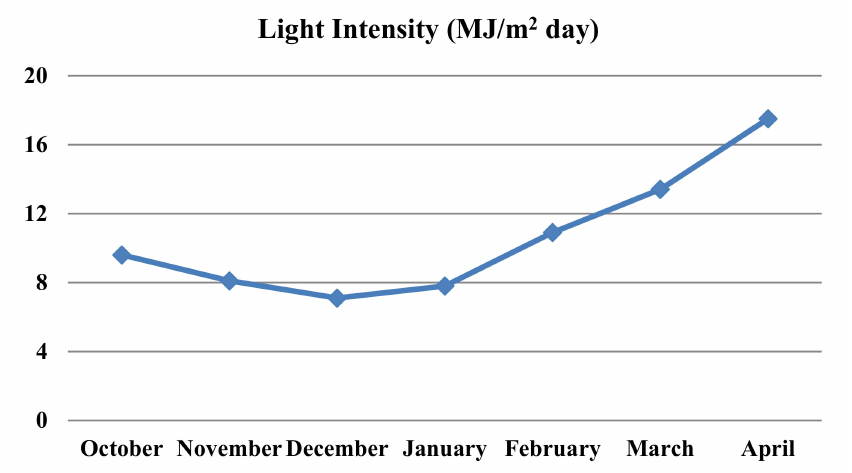
Figure 2. Average light intensity measured by a pyranometer during the cultivation time for the months between October (2011) and April